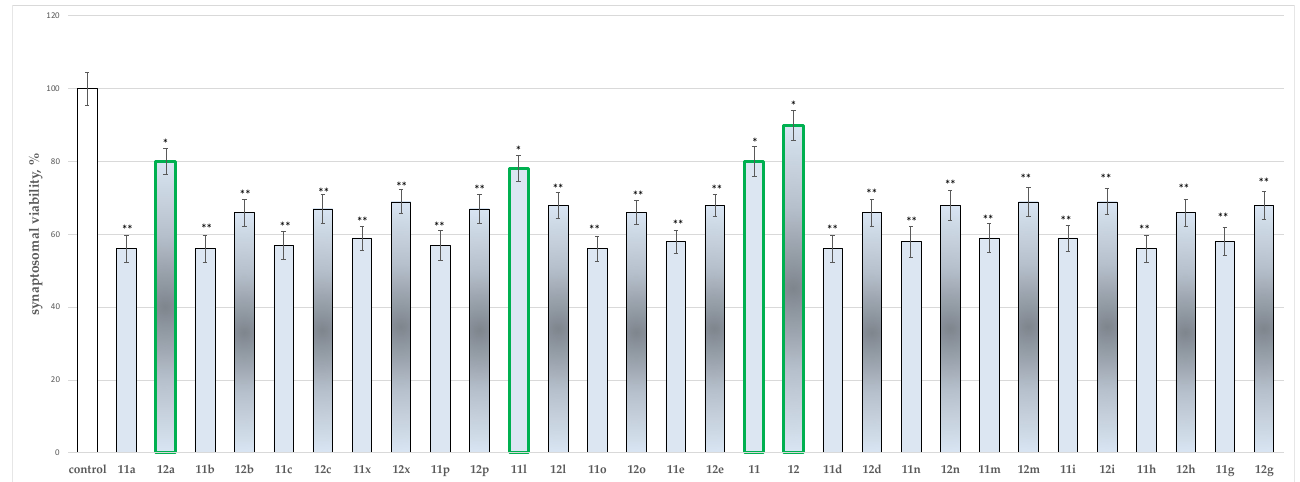
Figure 3. Major molecular interactions between 11 , 11l and 12 with the active site of MAO ‐ B (PDB: 1S3B ). The interactions are provided in 2D (( A , C , E ), respectively) and 3D (( B , D , F ), respectively) forms for each compound. The MAO ‐ B enzyme is depicted in gray, the FAD coenzyme is colored in red, and the MAO ‐ B inhibitors 11 , 11l and 12 are presented in blue mesh.